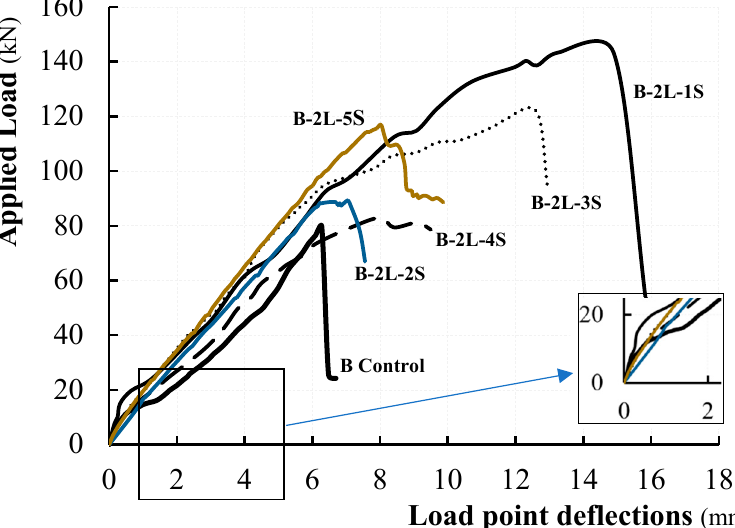
Figure 11. Load–deflection curves for beams strengthened with two layers of steel fabrics.